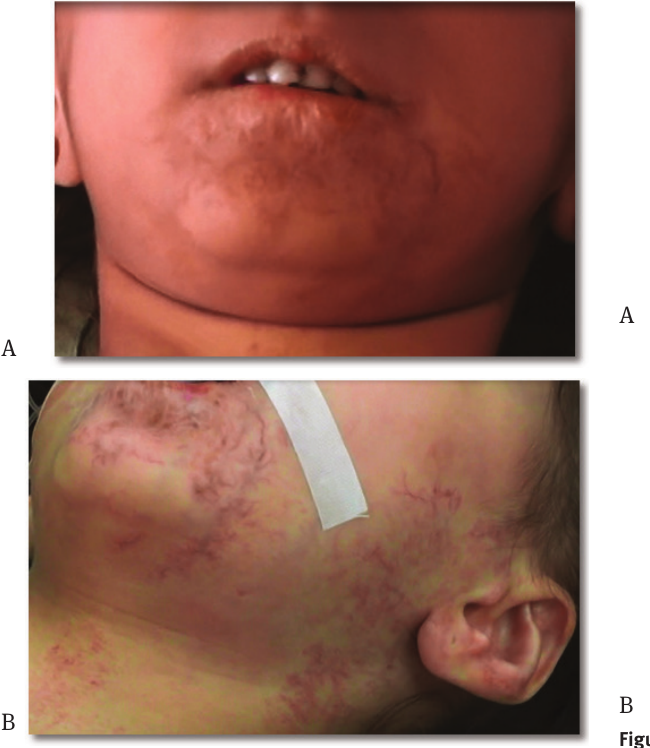
Figure 2 a-b: Left sided facial hemangiomas extending to neck.